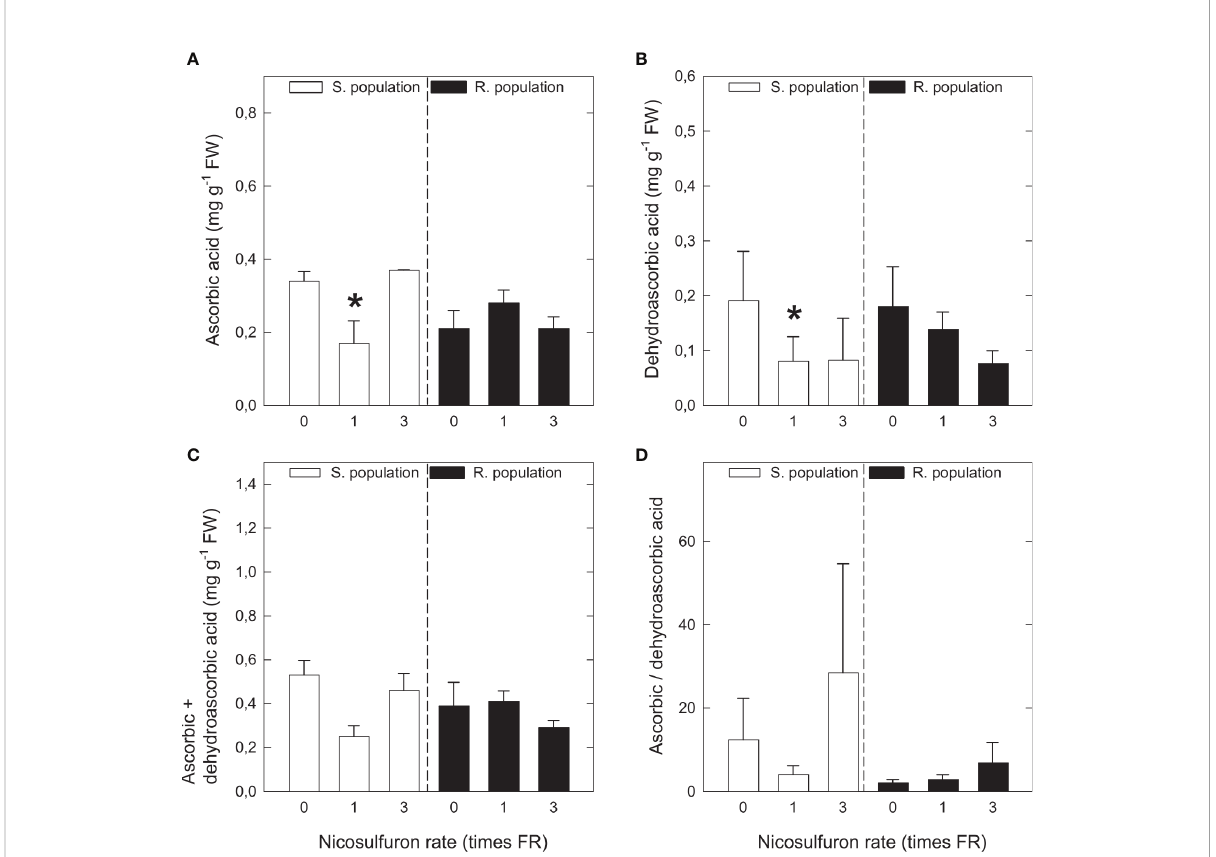
FIGURE 3 Ascorbic acid content (A) , dehydroascorbic acid content (B) , sum of ascorbic acid and dehydroascorbic acid (C) and ascorbic acid to dehydroascorbic acid ratio (D) in Amaranthus palmeri sensitive (S, white) and resistant (R, black) populations treated with different nicosulfuron rates (X axis, times recommended fi eld rate or FR, FR = 0.06 kg ha -1 ). Mean ± SE (n = 4). For each population, signi fi cant differences between treatments and their respective untreated are highlighted with asterisks (Student ’ s t test, p value ≤